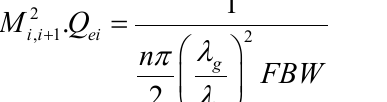
FIGURE 3. 4 th order bandpass waveguide filter